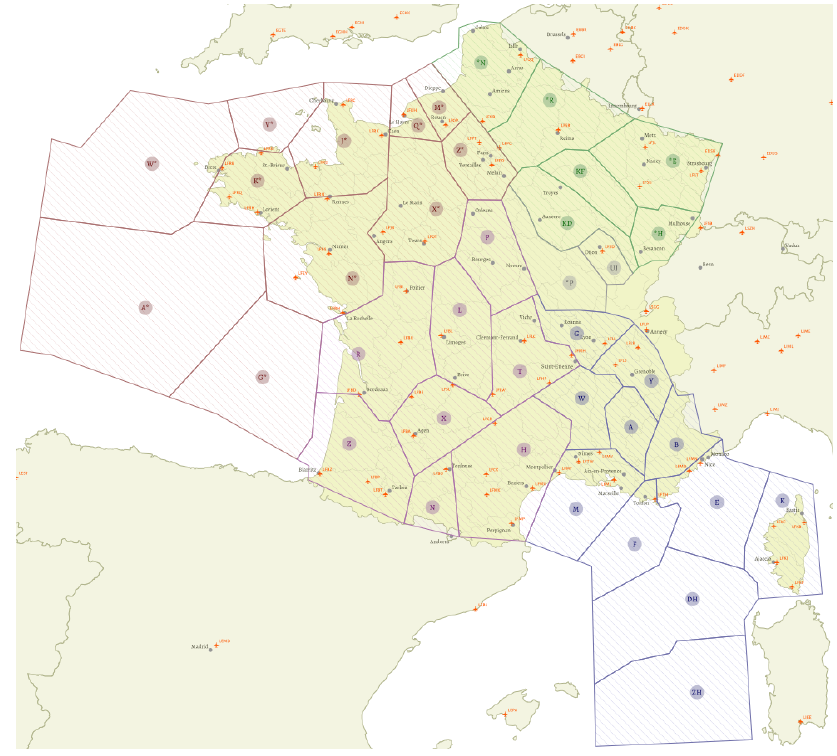
Figure 1. Sector division of the upper airspace of France [4].